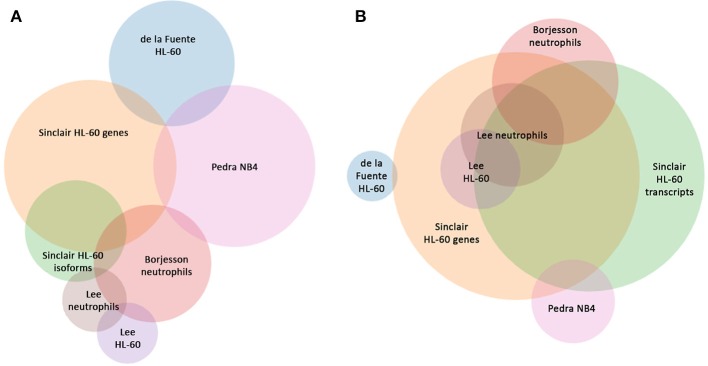
Comparison of shared differentially-expressed genes and GO Processes for A. phagocytophilum expression profiling in human myeloid cells and ex vivo neutrophils. (A) is based upon gene identifiers in each study and demonstrates a lack of overlap in shared differentially-regulated genes in six distinct studies, including five based on microarray analyses, and this study that separately analyzes gene-level and transcript level differential expression in ATRA-differentiated HL-60 cells. (B) is based upon GO processes enriched for each study and demonstrates the much greater similarity between studies. Venn circles are labeled by the first author of each publication from which data was derived; here Sinclair represents the data in this manuscript.